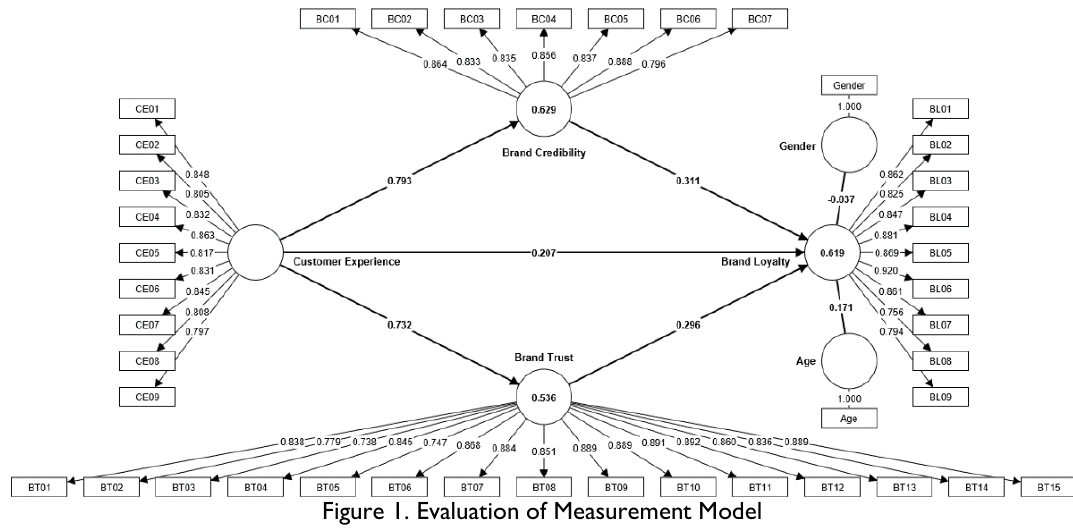
Figure 1. Evaluation of Measurement